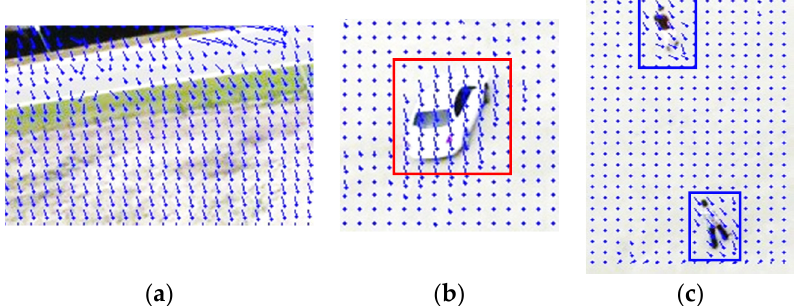
Figure 9. Result of motion vectors with image stabilization: ( a ) Background, ( b ) car, ( c ) people.